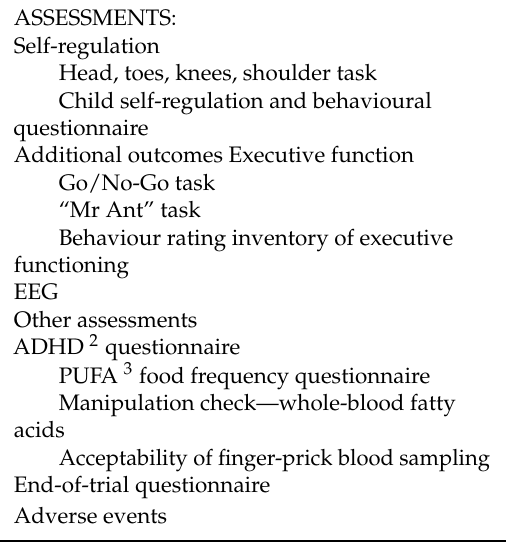
Table 2. Schedule of enrolment, intervention and